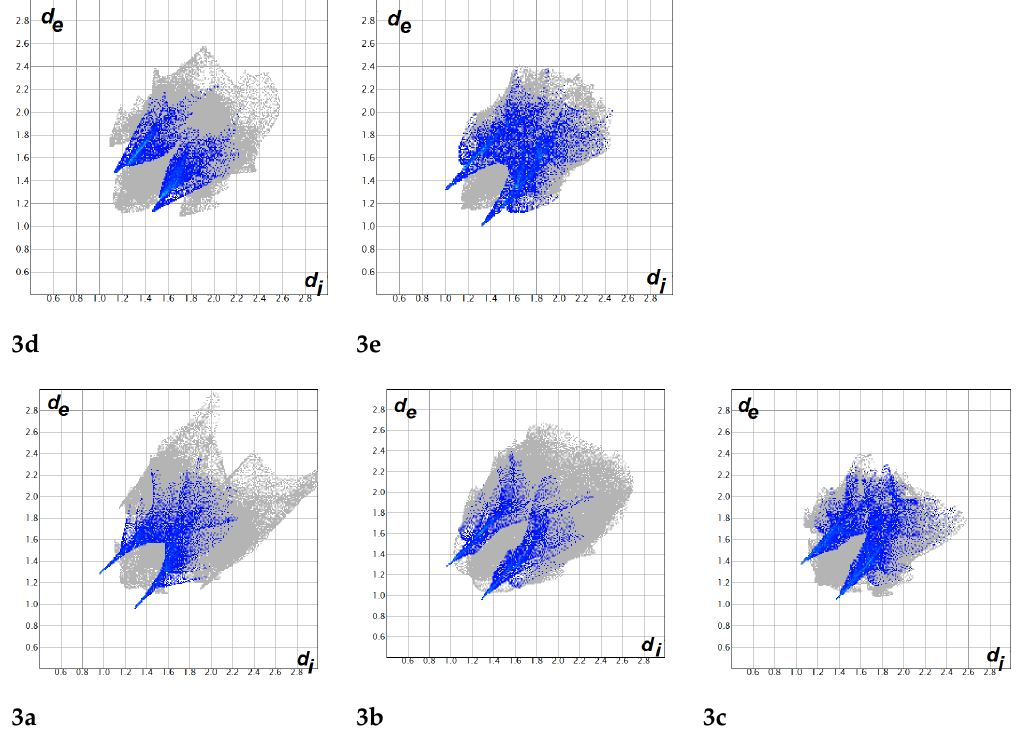
Figure 7. The decomposed fingerprint (FP) plots of the O ··· H contacts in the studied compounds: